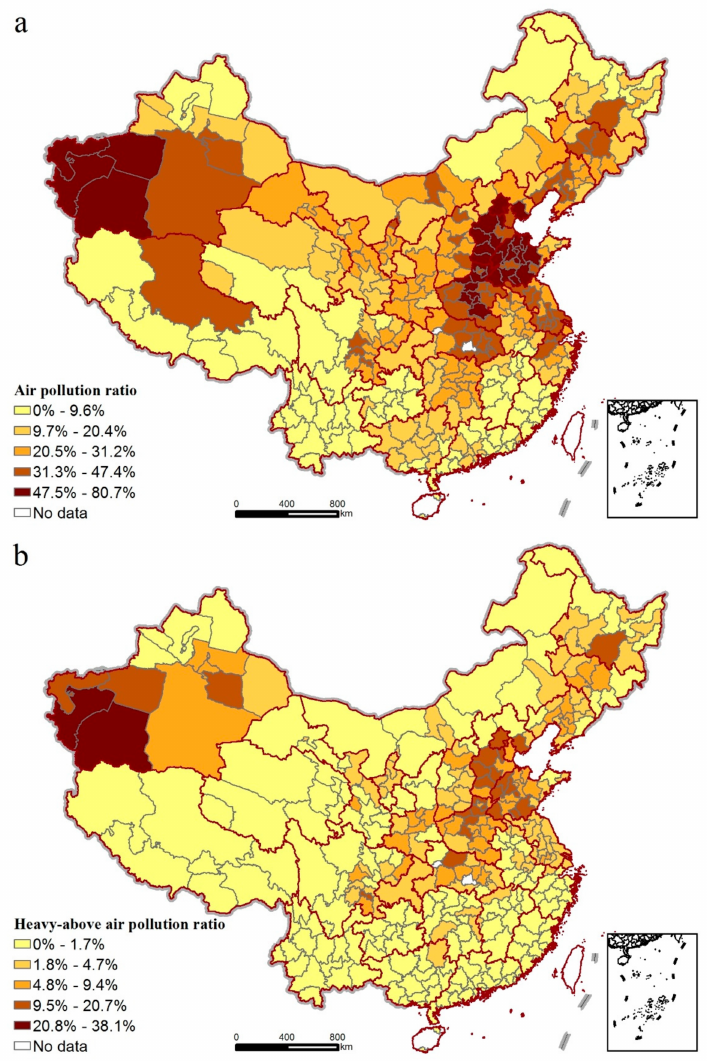
Figure 2. Spatial variations of air pollution ratio in China. ( a ) air pollution ratio ( b ) heavy-above air pollution